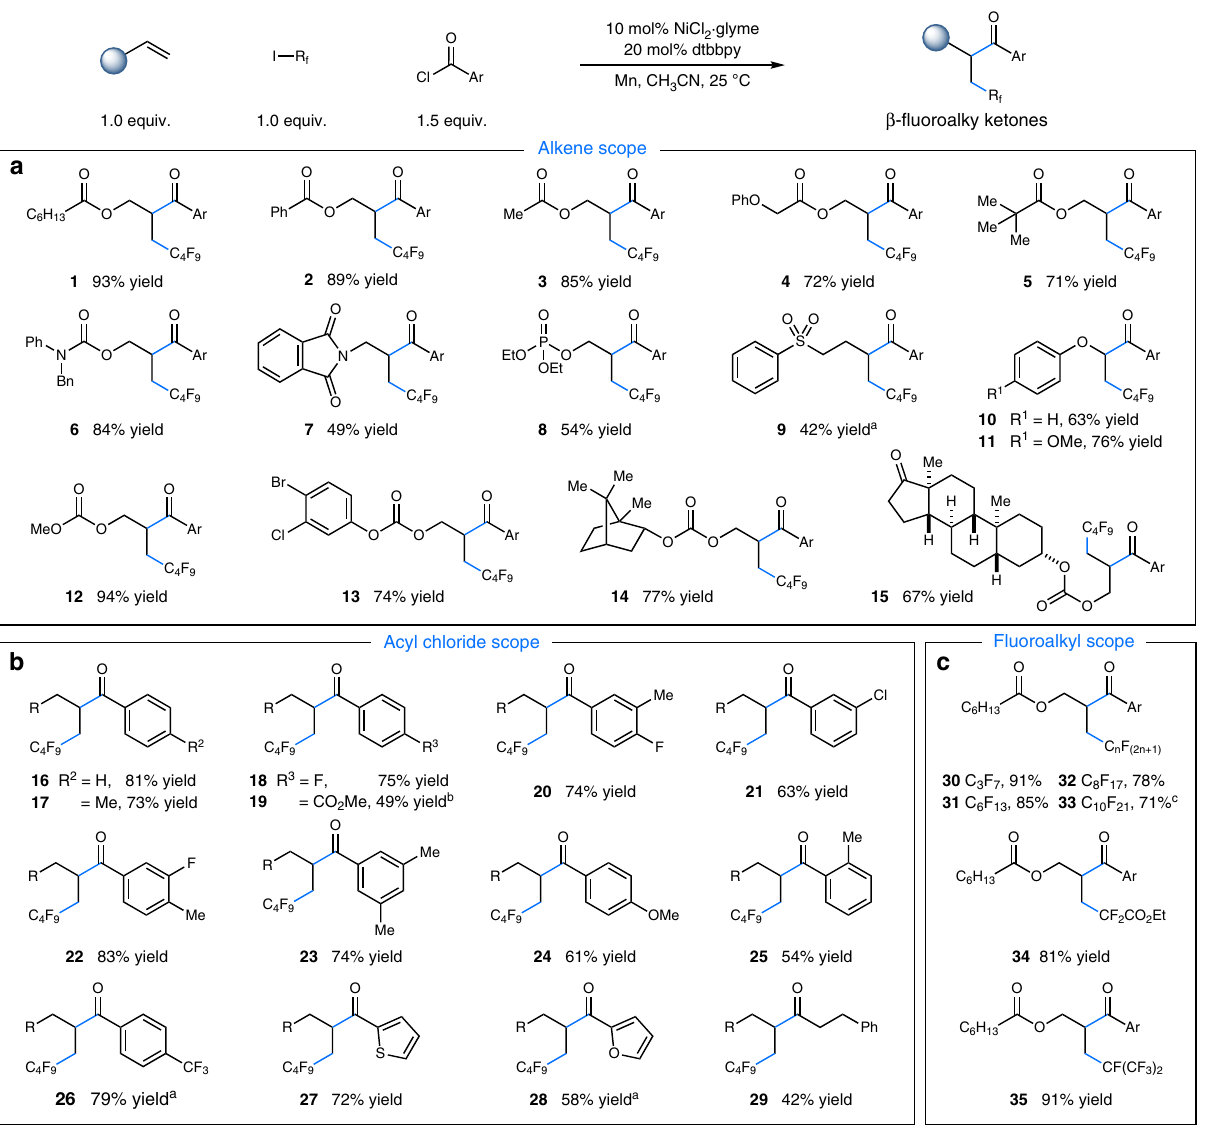
Fig. 2 Substrate scope. a Scope of alkenes. b Scope of acyl chlorides. c Scope of fl uoroalkyl iodides. Reaction conditions: NiCl 2 (cid:129) glyme (10 mol%), dtbbpy (20 mol%), alkene (1.0 equiv.), R f I (1.0 equiv.), acyl chloride (1.5 equiv.), Mn (3.0 equiv.), CH 3 CN [0.1 M], 25 o C, 20 h, see Supplementary Methods. All cited yields are isolated yields. Ar = 4- tert -butylphenyl, R = C 6 H 13 CO 2 . a Performed with 20 mol% NiCl 2 (cid:129) glyme. b Reaction concentration is 0.05M CH 3 CN. c Performed in CH 3 CN/DME (4:1) [0.1